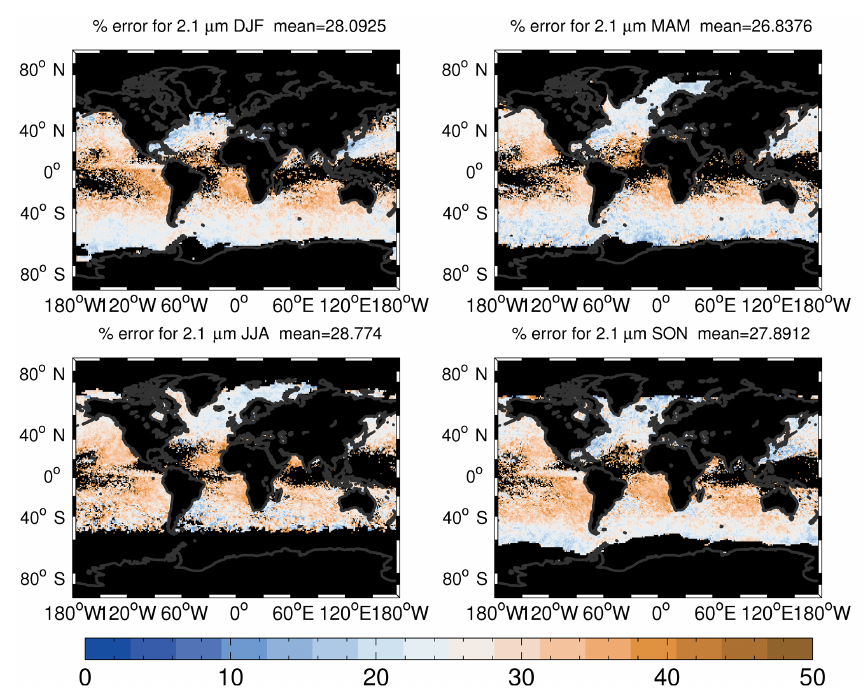
Figure 7. Seasonal mean percentage N d biases for the r e2.1 retrieval only.